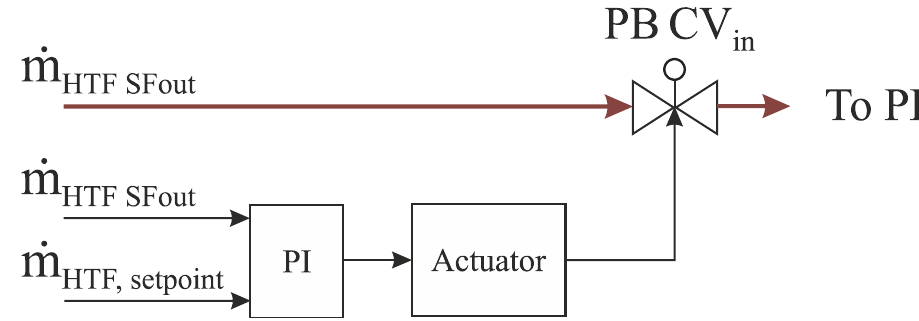
Figure 5. HTF control valve at the outlet of the SF (simplified).